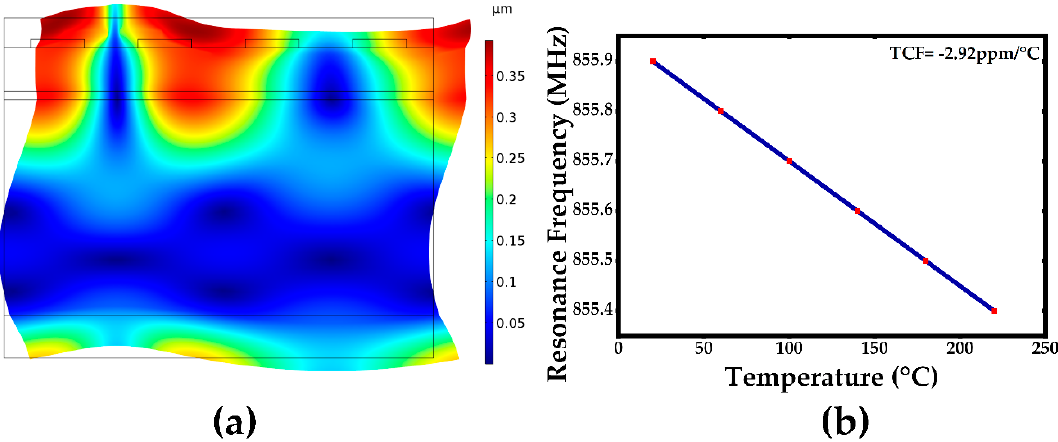
Figure 6. ( a ) The simulated acoustic wave mode shape (resulting displacement) with double temperature compensation layer, ( b ) temperature dependent of resonance frequency of acoustic wave resonator.